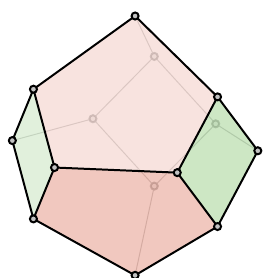
Figure 1 . The A 3 Stasheff associahedron, relevant for six-particle scattering. The positive region in the space of kinematics amounts to the interior of the polytope, whereas pentagonal faces correspond to double-scaling limits, and square faces to soft (or equivalently multi-Regge) limits. The two red pentagonal faces represent the two possible double scaling limits DS1 and DS2 that are considered in this